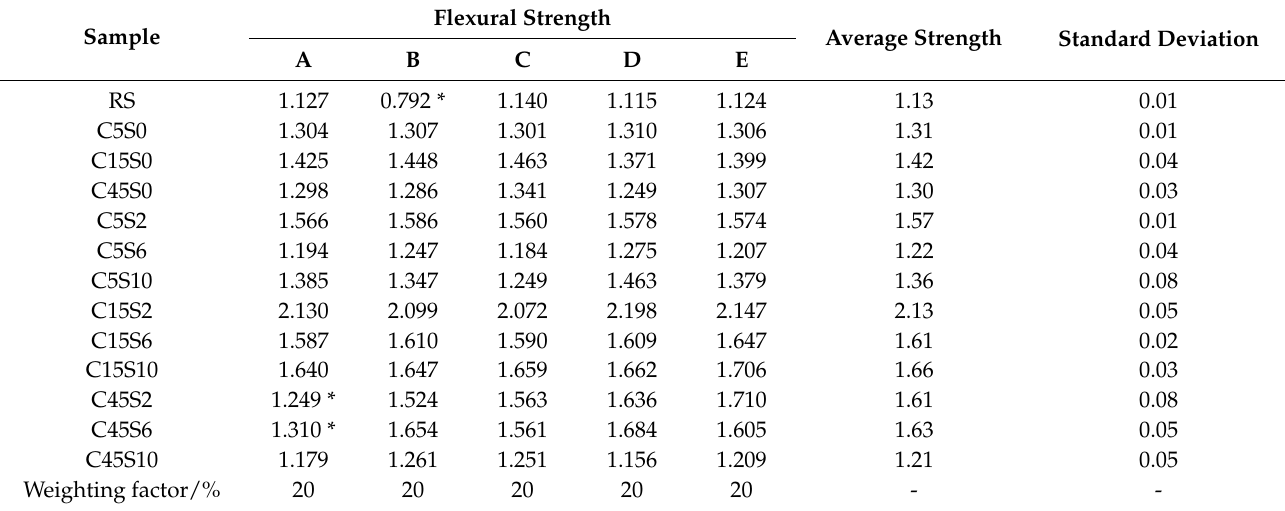
Table A1. Original data of flexural strength test (unit: